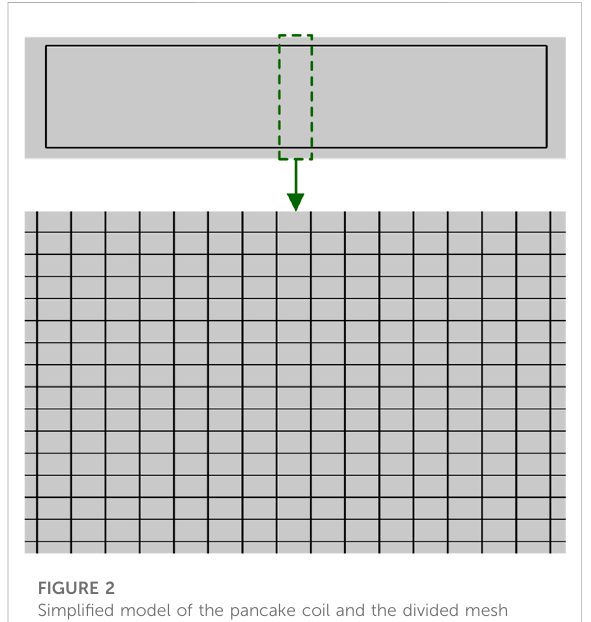
FIGURE 2 Simpli fi ed model of the pancake coil and the divided mesh (locally enlarged). FIGURE 3